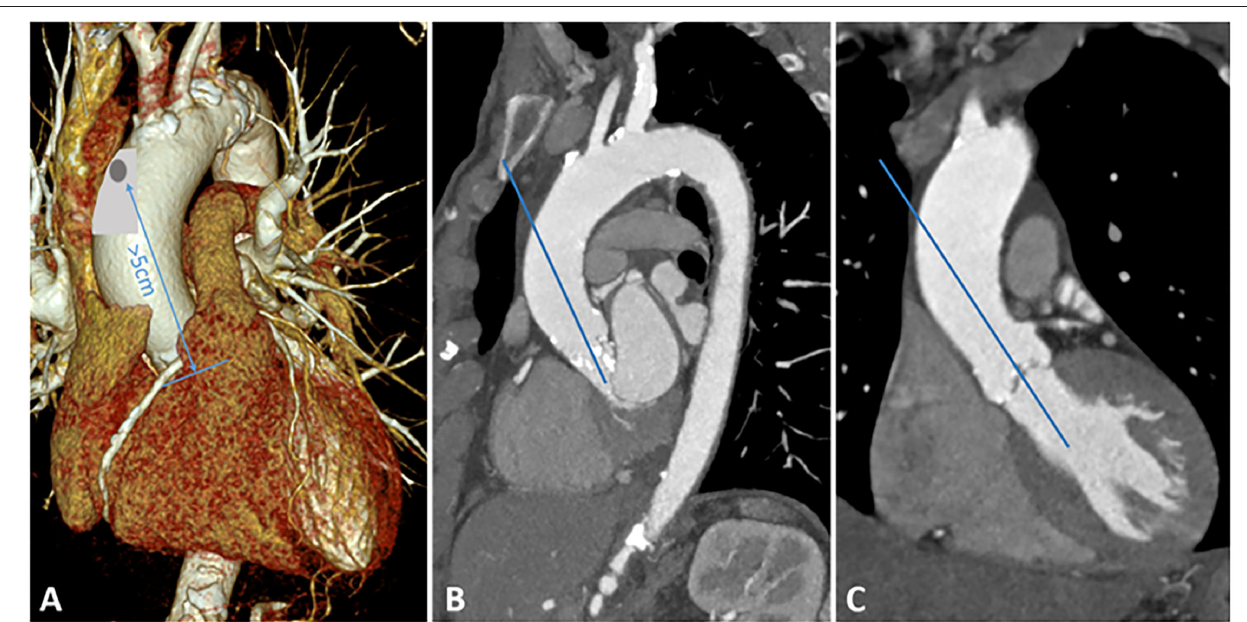
FIGURE 1 | Preoperative MSCT. (A) 3D reconstruction of the aortic arch, appropriate location for aortic puncture is highlighted in gray. The distance between the puncture and the aortic annulus should be at least 5cm. (B) Sagittal plane of the aortic arch. (C) Coronary plane of the ascending